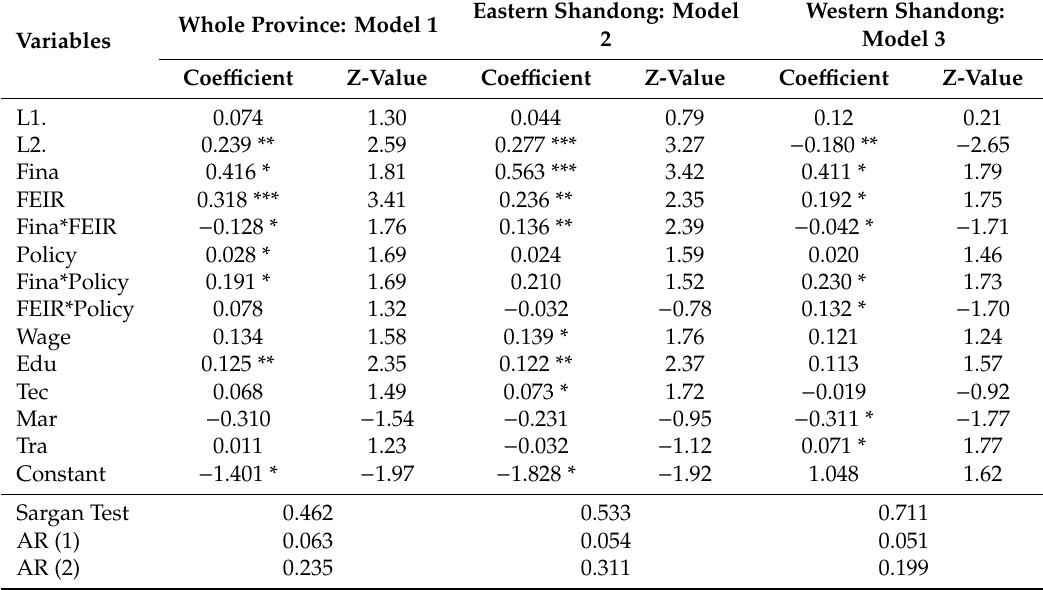
Table 5. Robustness test